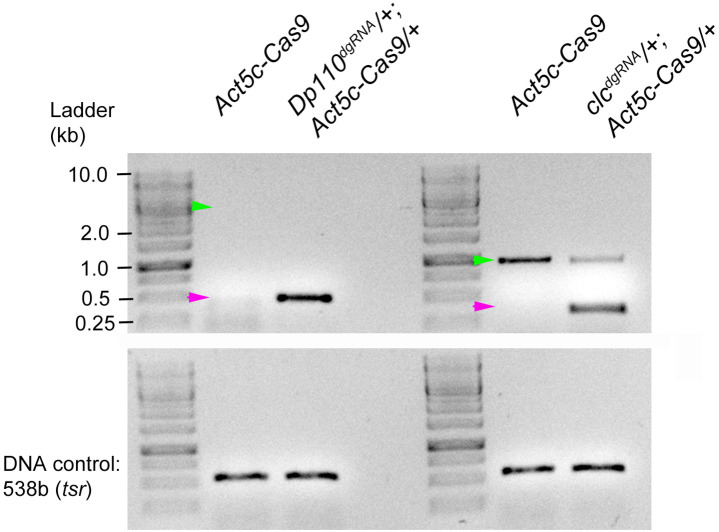
Genomic deletion using Gal4/UAS system.(A) Genomic PCR of Pi3K92E (Dp110) as an example to show that when comparatively larger genomic regions are deleted (in this case ~4 Kb- See Supplementary file 1), only the mutant band is amplified by the genomic PCR. Position of the expected wild-type band shown in green and mutant band in magenta. (B) When a similar experiment is done for clc gene, where the expected WT PCR product is smaller (~1 kb- see Supplementary file 1), it is amplified by PCR along with the deletion product. Position of the expected wild type band shown in green and mutant band in magenta. In both the cases, deletion was obtained by crossing Act5c-Cas9 with transgenic lines ubiquitously expressing dgRNAs.